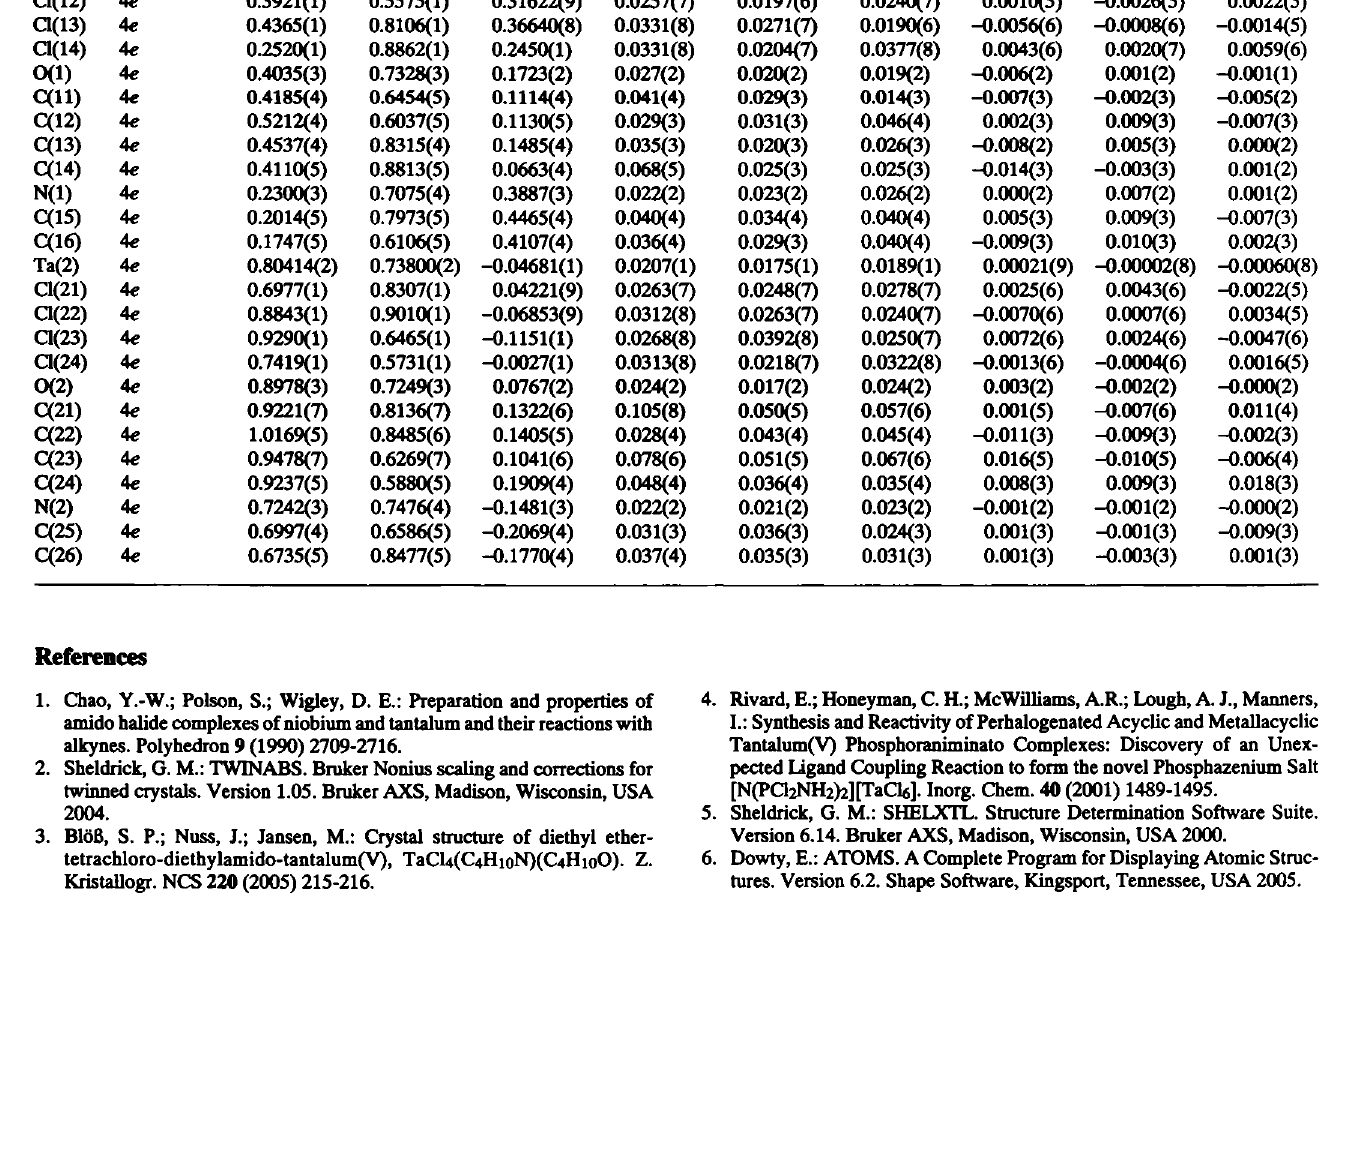
Table 3. Atomic coordinates and displacement parameters (in Ä 2